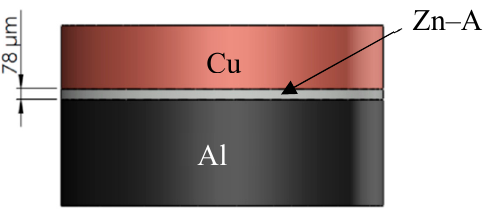
Figure 1. Test piece of solder for static tensile test. Unit: mm.